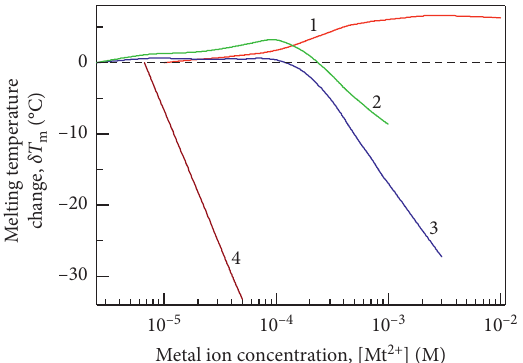
Figure 5: Changes in the thermal stability of poly(I:C) induced by various types of interactions with Mt 2+ : 1: with phosphates; 2–4: with bases: 2: Ni 2+ ; 3: Cd 2+ and Zn 2+ ; 4: Cu 2+